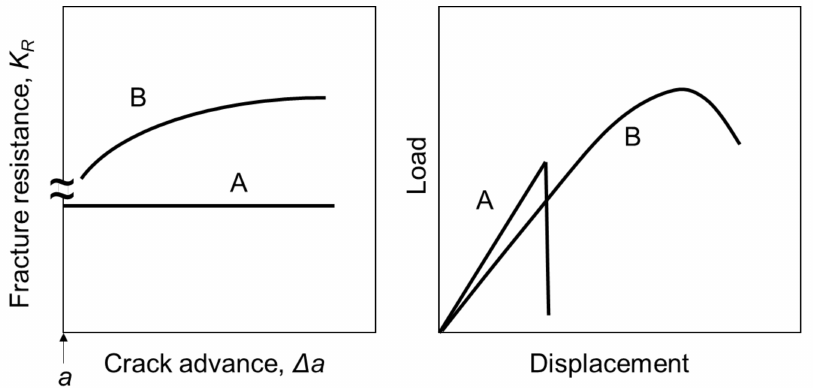
Figure 1. Schematic drawing of R-curve behaviors and load–displacement curves of ceramic frac- ture [2,8]. A : brittle ceramics, B : toughened